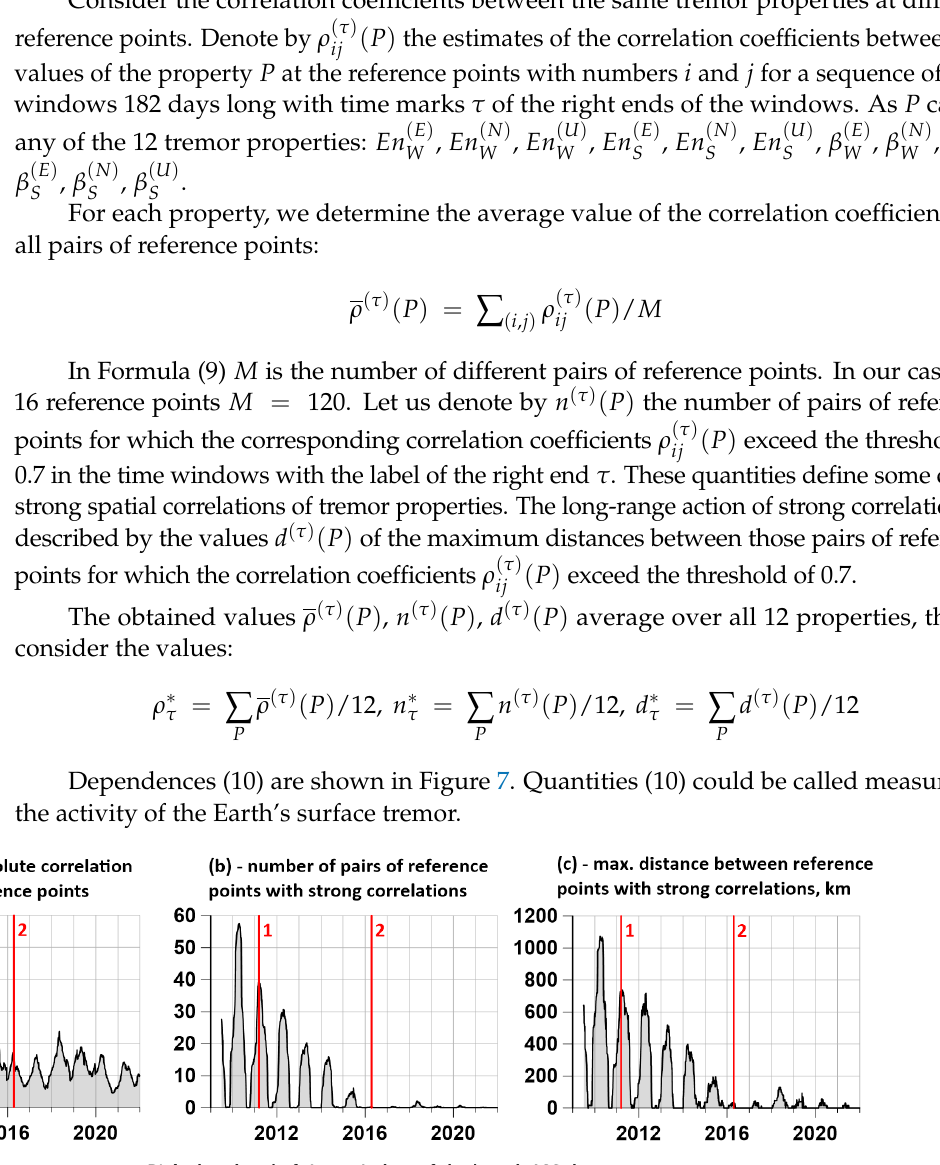
Figure 7. ( a ) is a plot of mean correlations ρ ∗ τ ; ( b ) is a graph of the average number n ∗ τ of pairs of control points for which the correlations exceeded the threshold of 0.7; ( c ) is a graph of the average maximum distances d ∗ τ between those pairs of control points for which the correlation coefficients exceed the threshold of 0.7. Vertical red lines indicate time moments of earthquakes: 1—Tohoku, 11 March 2011, M = 9.1; 2—Kumamoto, 16 April 2016, M = 7. For each reference point with a number j = 1, . . . , 16, it is possible to calculate how ρ ( ) j τ of the reference points changes in each time window. When calculating the values average is made over all 12 properties of the tremor of the Earth’s surface. Graphs of values ( j ) ρ τ are shown in Figure